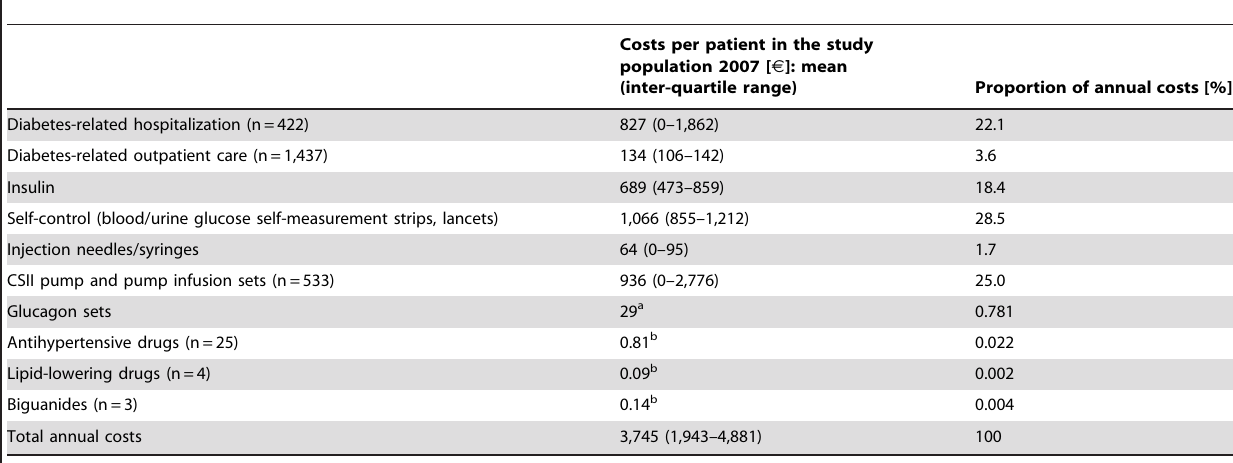
Table 4. Diabetes-related costs per patient in the study population (age group 8–18 years, onset 1993–1999 at 0–4 years) in 2007.